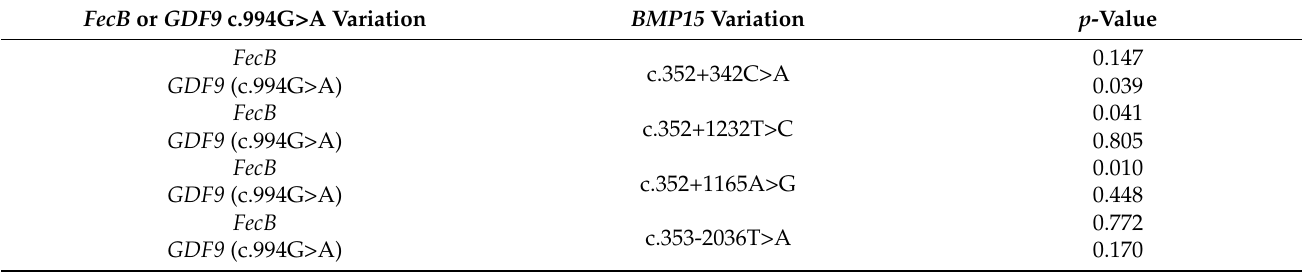
Table 5. Results of interactive effects between FecB or GDF9 c.994G>A and four variations associated with litter size in the BMP15 gene. FecB or GDF9 c.994G>A